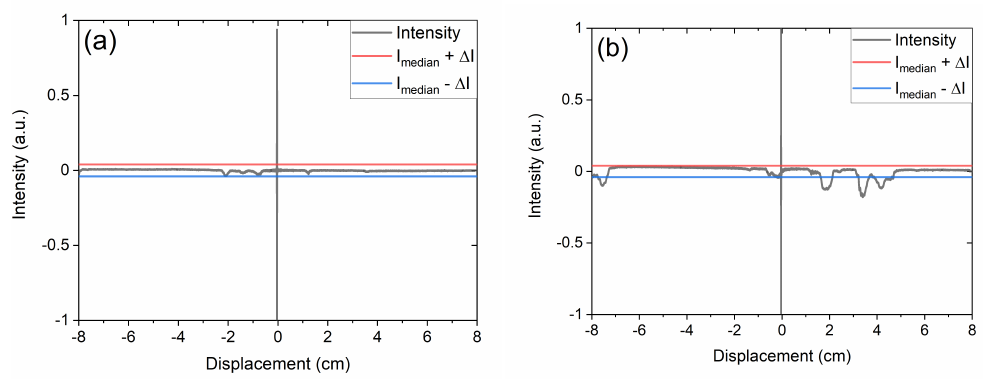
Figure 2. Visual representation of the interferogram based cloud filter. ( a ) shows an interferogram with a weak cloud influence and ( b ) an interferogram with a strong influence. Both interferograms are from different detector pixels for the same measurement. If more than 10 percent of the intensity values are off the defined boundaries, the measurement of the detector pixel is not taken into account when averaging.